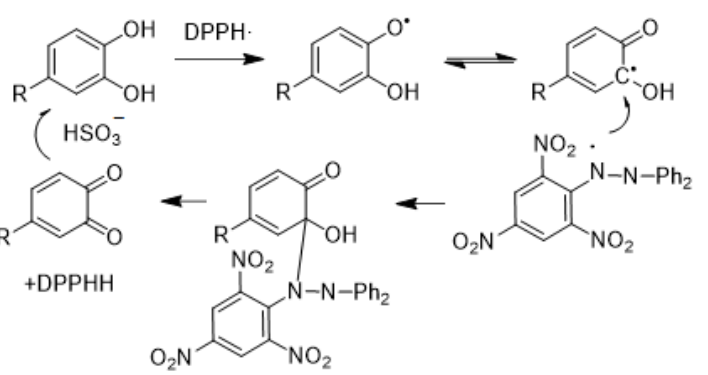
Figure 1. Reaction between DPPH and radical [7].